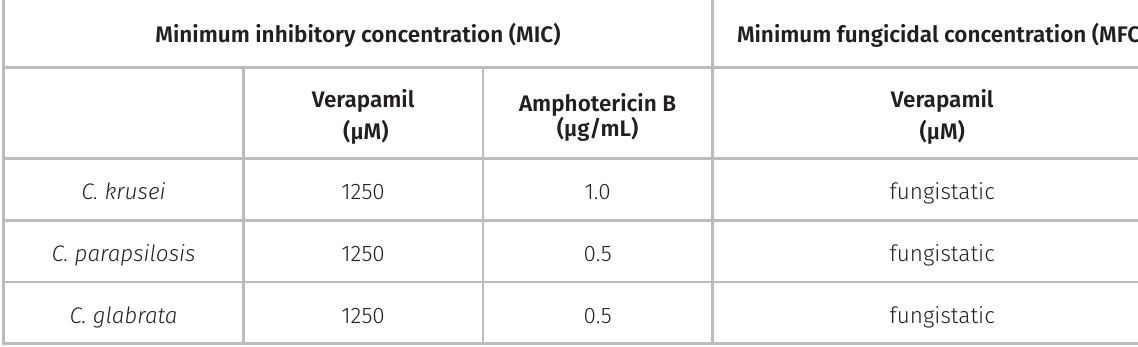
Table I. Susceptibility of non- albicans Candida species to verapamil: Minimum Inhibitory Concentration (MIC) and Minimum Fungicidal Concentration (MFC) of